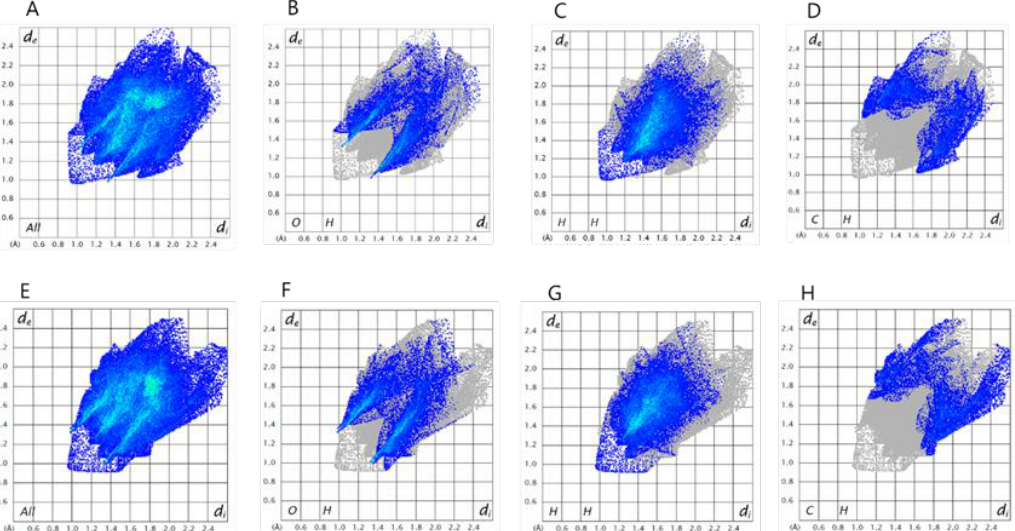
Figure 7. Two-dimensional fingerprint plots of the most important intermolecular contacts in each molecule I and II . For I : full ( A ) and resolved into O···H ( B ), H···H ( C ), C···H ( D ). For II : full ( E ) and resolved into O···H ( F ), H···H ( G ), C···H ( H ).